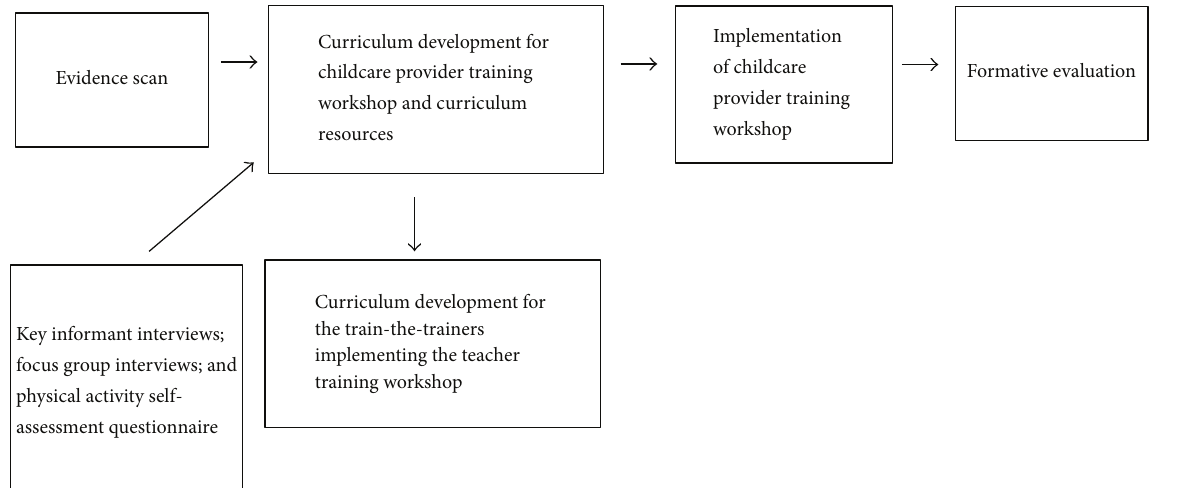
Figure 1: Flow diagram for curriculum